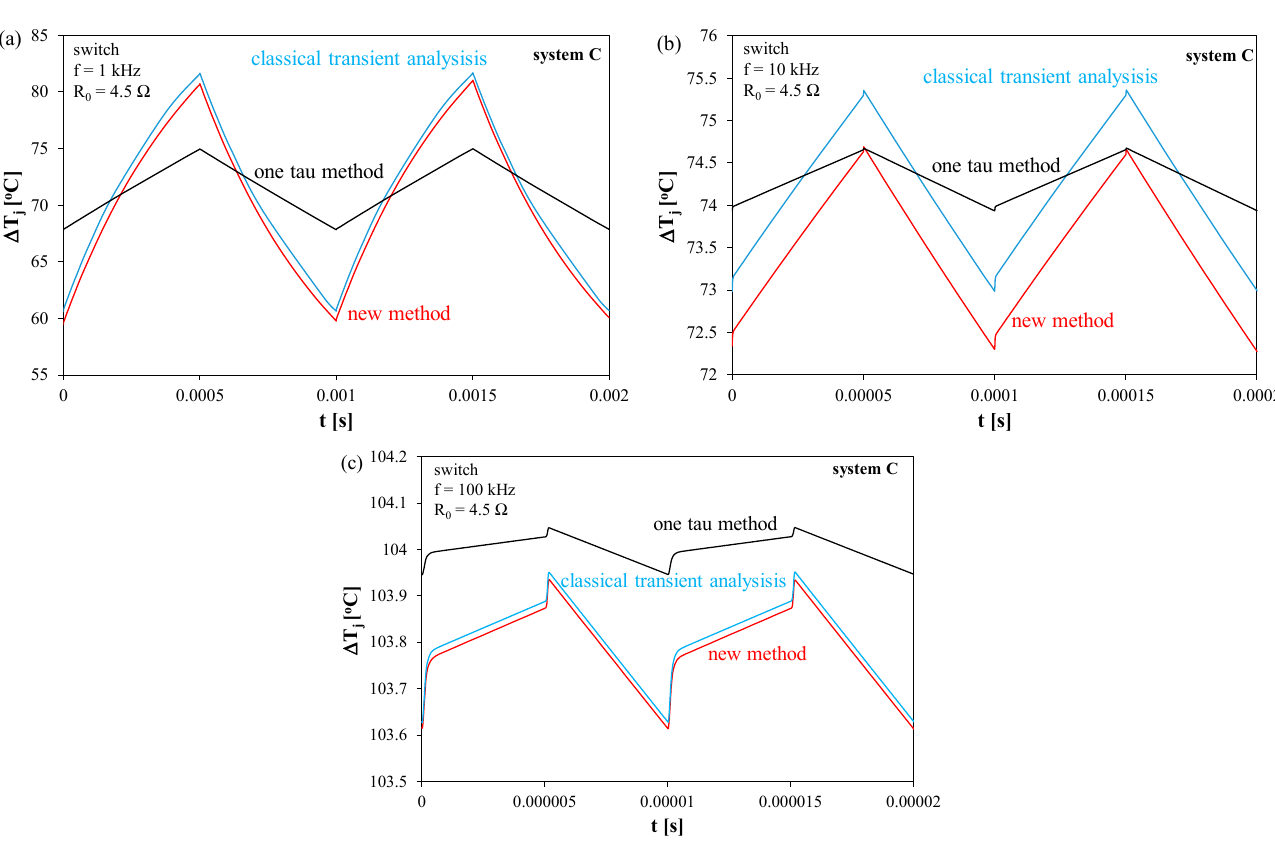
Figure 5. Computed waveforms of the junction temperature of the transistor operating as a switch with the cooling system C at frequency f equal to 1 kHz ( a ), 10 kHz ( b ) and 100 kHz ( c ). As can be observed, the results obtained with the use the new method and the classical transient analysis are very close to each other. The differences between these results do not exceed 1 ◦ C and the peak-to-peak values obtained with these methods are practically the same. In contrast, the results obtained with the one tau method are characterized by the same average value as the other considered methods, but the peak-to-peak values of the obtained waveforms are more than two times lower than for the other methods. It is also worth observing that an increase in the switching frequency from 1 to 100 kHz causes a visible decrease (over 20 times) in the peak-to-peak value of the considered temperature and an increase in the average value of this temperature. The presented results prove the usefulness of the proposed method. The calculation time for the new method is five times shorter than for the classical method at a frequency equal to 1 kHz. The computation time of the new method does not depend on the frequency and values of thermal time constants. In contrast, this time, while using the classical method, increases nearly linearly with an increase in the values of the longest thermal time constant and switching